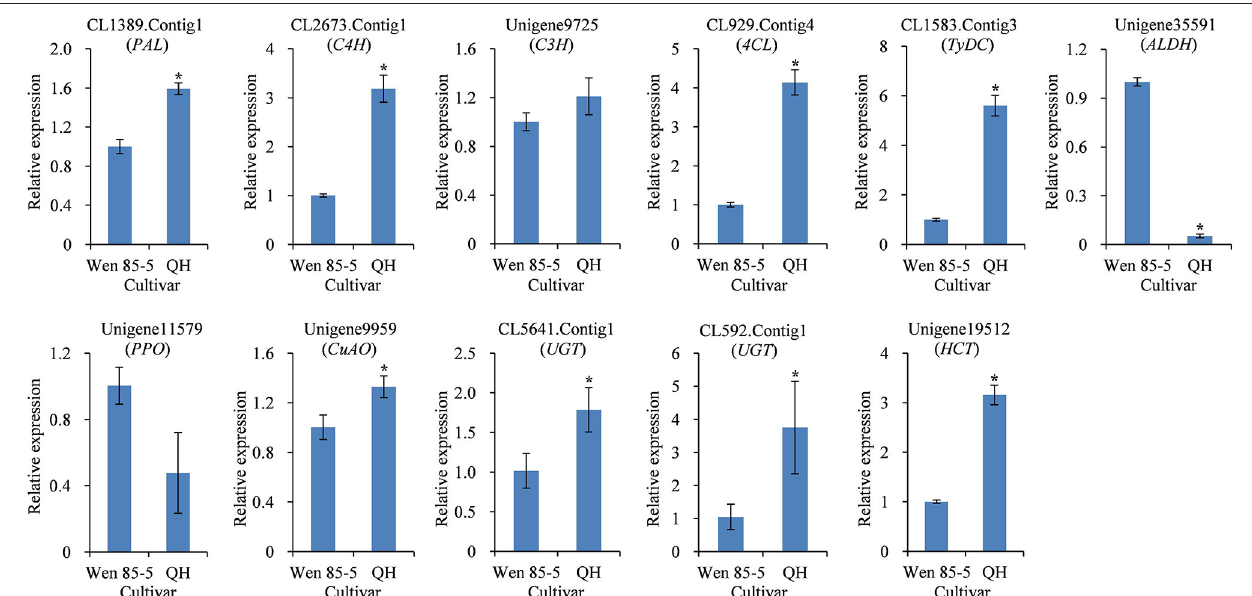
FIGURE 8 | Expression of candidate genes involved in biosynthesis of acteoside in tuberous roots of Wen 85-5 and QH at 30 July, 2015. These genes expression level were all determined by Real-time PCR. Vertical bars indicate the standard deviation of three biological replicates. Asterisks indicate a significant difference at the p < 0.05